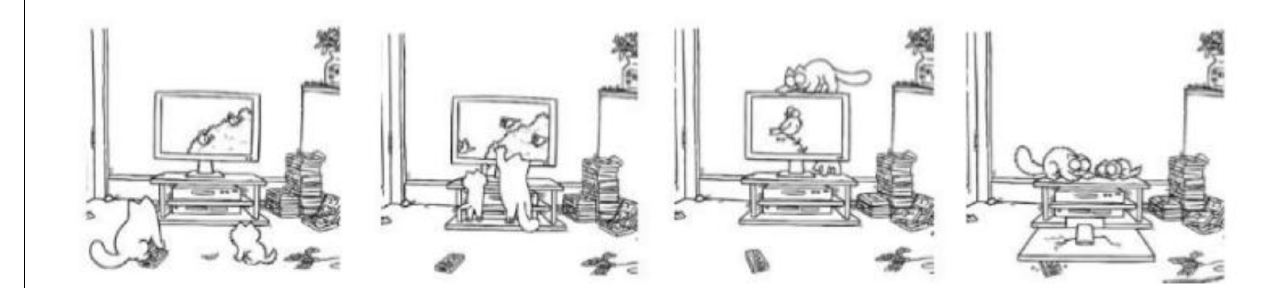
FIGURE 1 | An example comic strip, taken from “Simon’s Cat” by Simon Tofield. Reprinted with permission. © Simon’s Cat